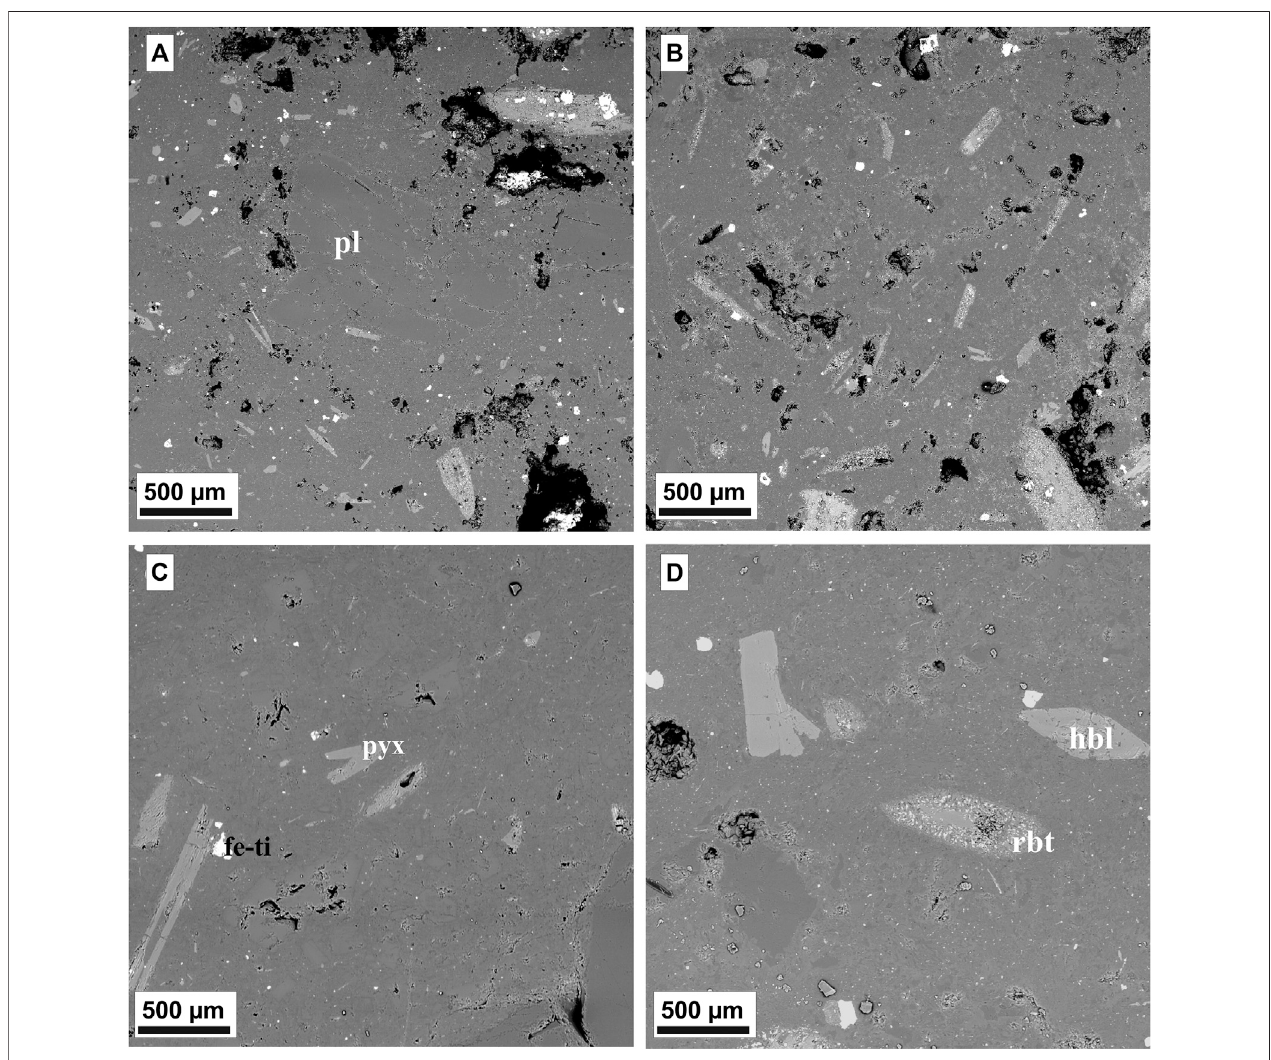
FIGURE 12 | A and C are of sample CHL-MC-15 (Buenavista Dome rocks) and (B, D) are of sample CHL-PIS-25 (Buenavista stream valley samples). Plagioclase (pL), hornblende (hbl), pyroxene (pyx) and Iron-Titanium oxides (Fe-Ti) are labeled in the images. A rim breakdown texture is also labeled in D (rbt).